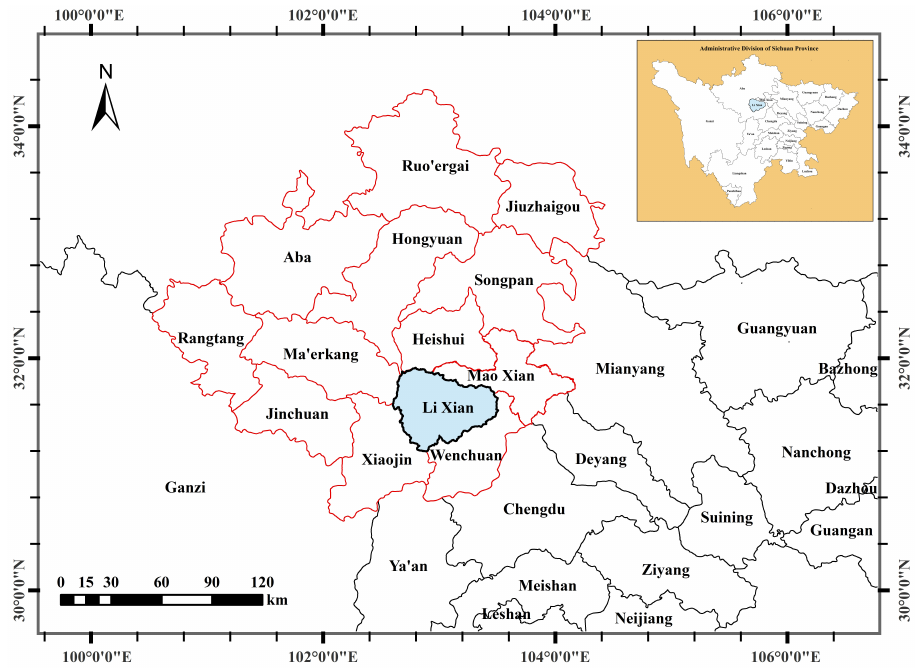
Figure 1. The location of Li County in